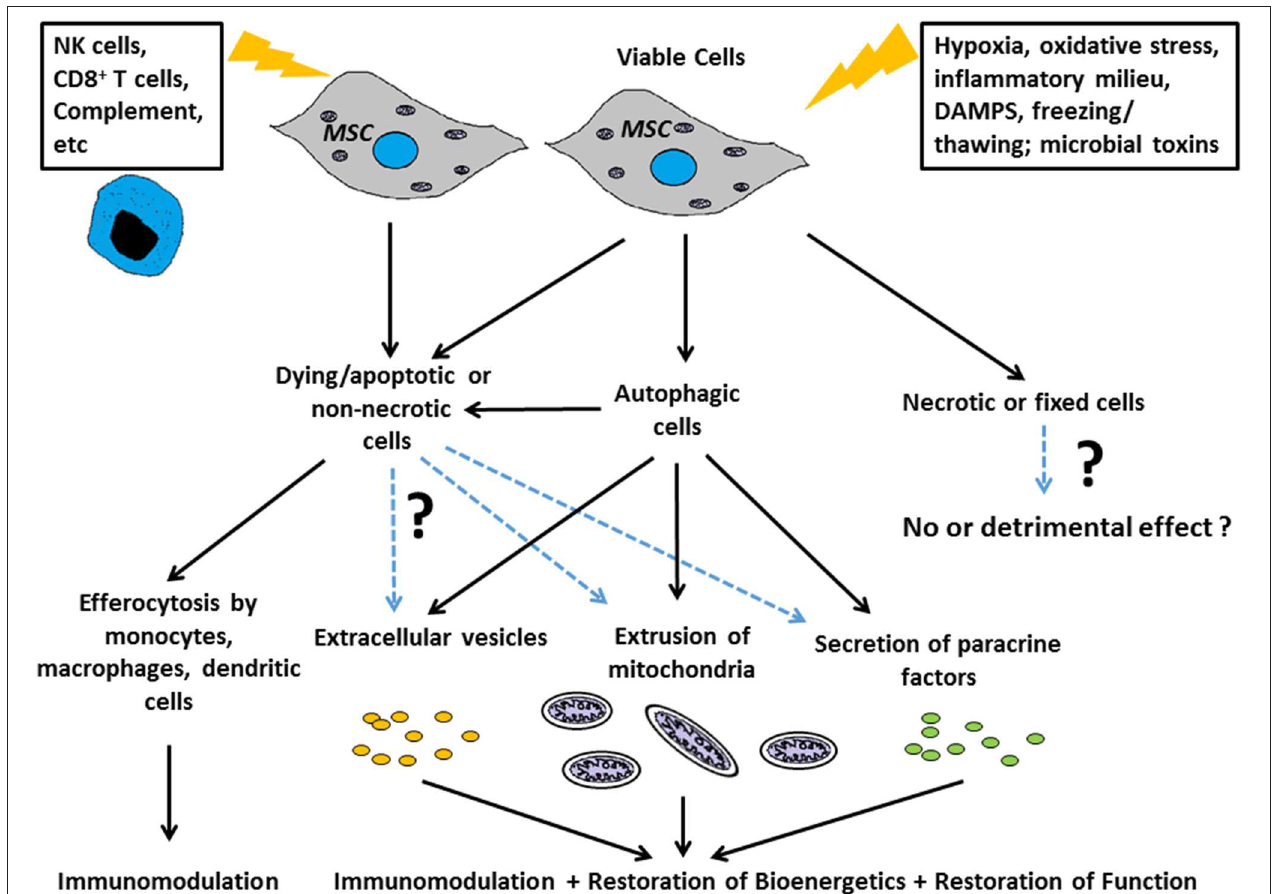
FIGURE 1 | Scheme for how the necrobiology of MSCs influences therapeutic efficacy Putative mechanisms include: as live cells through paracrine mechanisms, and through the cellular processes associated with morphological, biochemical, and molecular changes which predispose, precede, and accompany cell death. These necrobiotic processes include the response to dying and non-necrotic MSCs, the alteration of MSC biology by autophagy, and the delivery of MSC derived mitochondria or EVs to target cells and